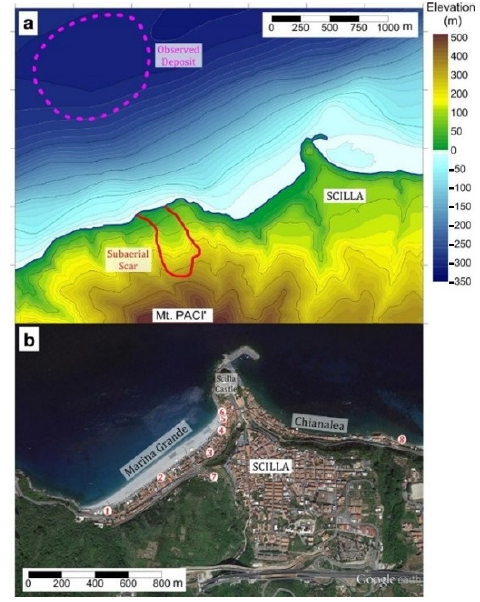
Figure 3. ( a ) Topo-bathymetry of the region where the slide occurred. ( b ) Satellite image from Google Earth of Scilla, with Marina Grande and Chianalea (Zaniboni et al, 2016).